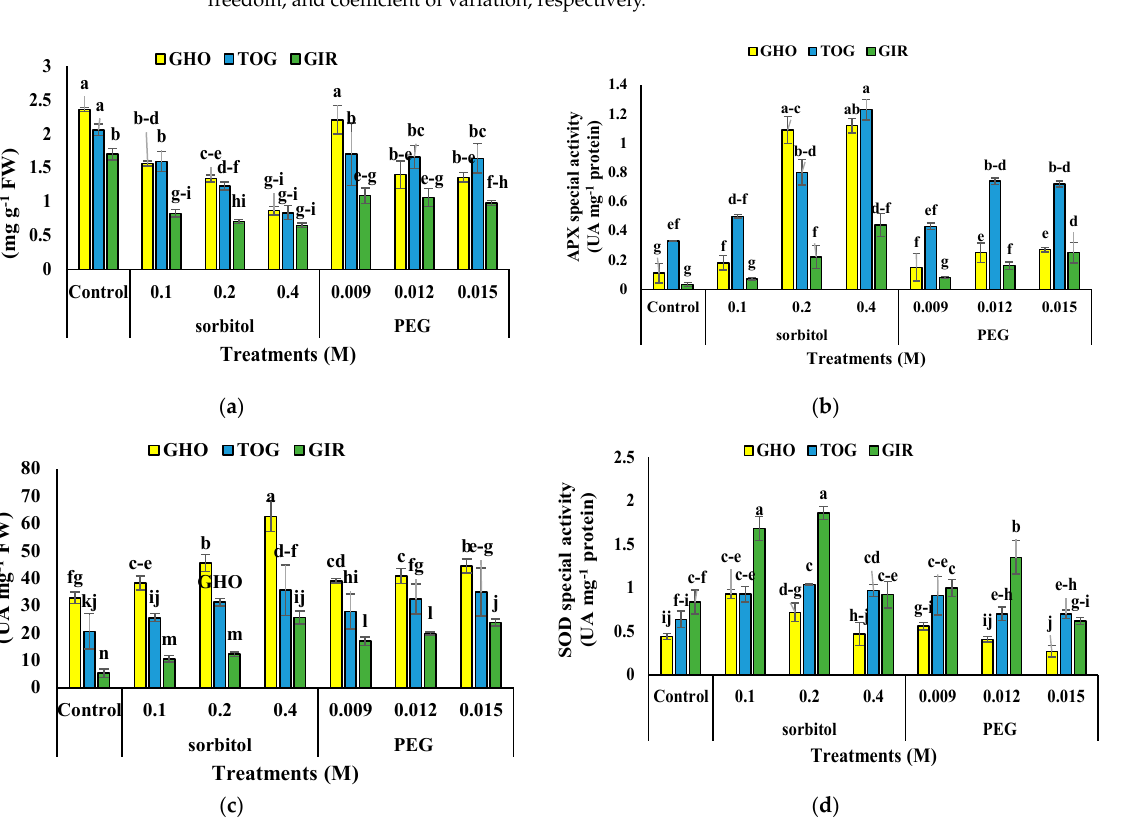
Figure 3. The effects of PEG and sorbitol on total protein content ( a ), APX activity ( b ), GPX activity ( c ), and SOD activity ( d ) of three melon genotypes. Different letters are significantly different based on Duncan’s multiple range test ( p ≤ 0.05). GHO, TOG, and GIR are the Ghobadloo, Girke, and Toghermezi genotypes, respectively. Table 4. The ANOVA for the effects of PEG and sorbitol on the total soluble protein content and the antioxidant enzyme activity of three melon genotypes under in vitro conditions.